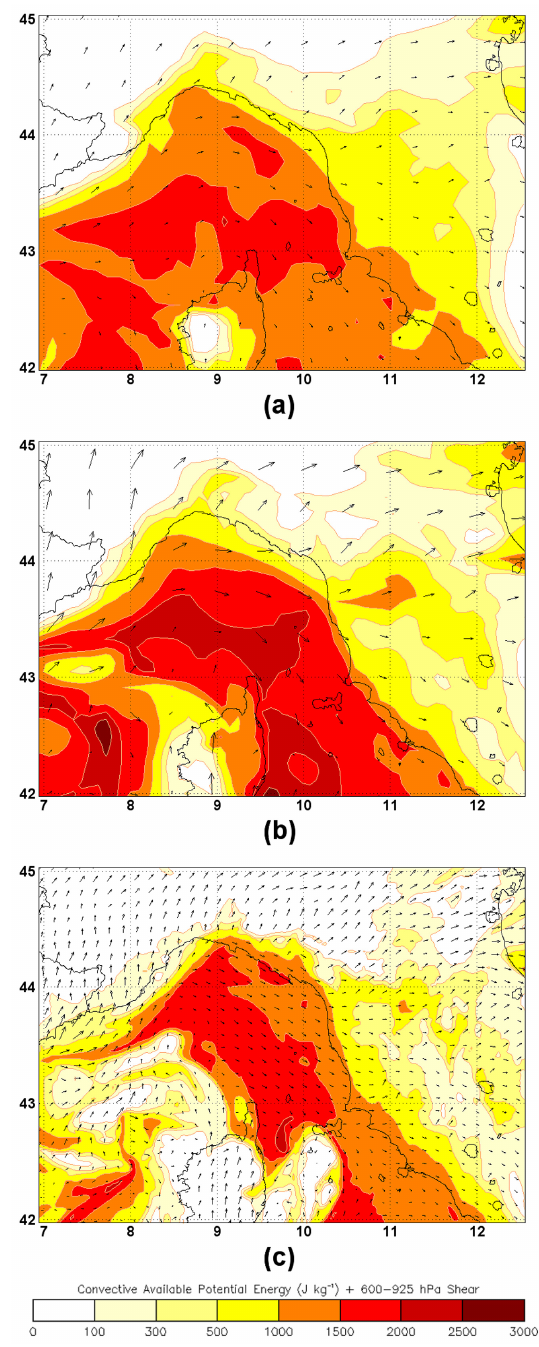
Figure 9. Contour plot of the CAPE forecast at 15:00UTC of 26 October 2012 over the LT hydrometeorological site and 600– 925hPa shear for the 0.1 ◦ BOLAM from the operational SIMM (a) , and the 0.07 ◦ BOLAM (b) and the 0.0225 ◦ MOLOCH (c) from the HyMeX-based SIMM. The forecasts were initialised at 12:00UTC of 25